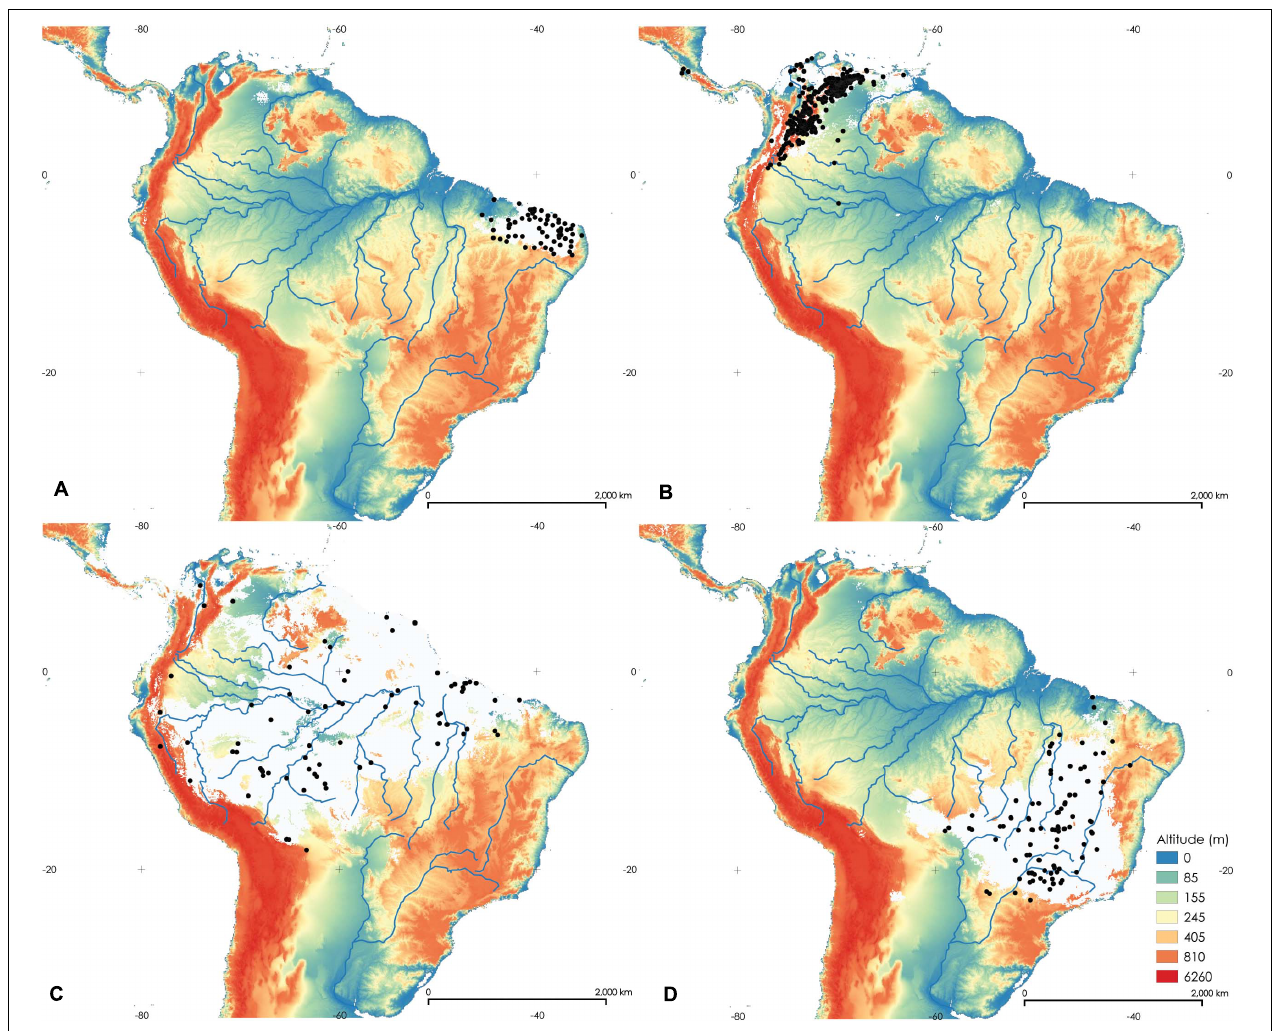
FIGURE 6 | Maps of the potential distribution of Rhodniini based on 19 bioclimatic variables in the study area. prolixus group— Rhodnius nasutus (A) , R. prolixus (B) , R. robustus (C) , (D) R. neglectus . The white areas comprise the probability value at which 90% of the presence points fall within the potential area. The black dots indicate records of each